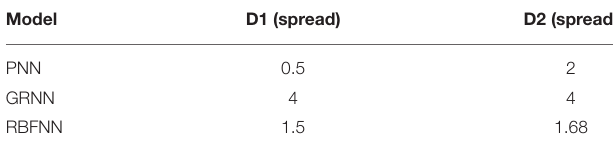
TABLE 3 | SPREAD value for PNN, GRNN, and